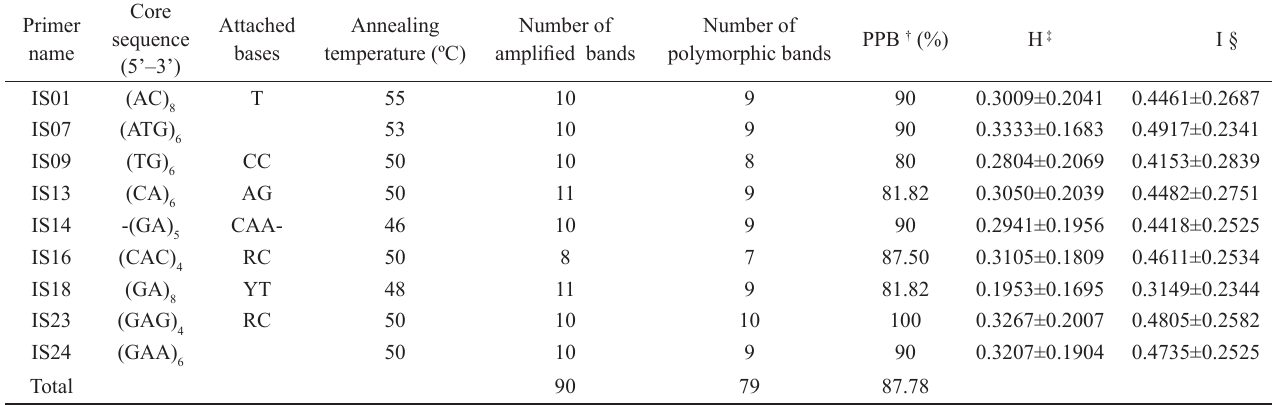
Table 3 . Inter-simple sequence repeat (ISSR) primers and corresponding information.